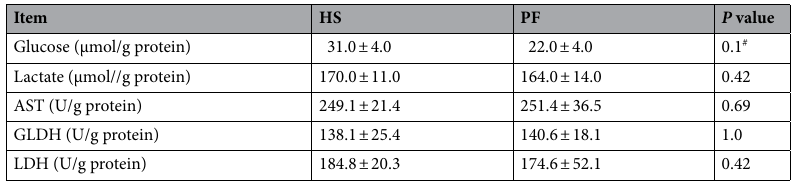
Table 1. Glucose and lactate concentrations and enzyme activities of AST, GLDH and LDH in jejunal mucosa of dairy cows exposed to heat stress (HS) or pair-feeding (PF) at thermoneutrality for 4 days. HS n = 5, PF n = 5. Data are given as mean ± SEM (MWU test). # 0.06 < P <